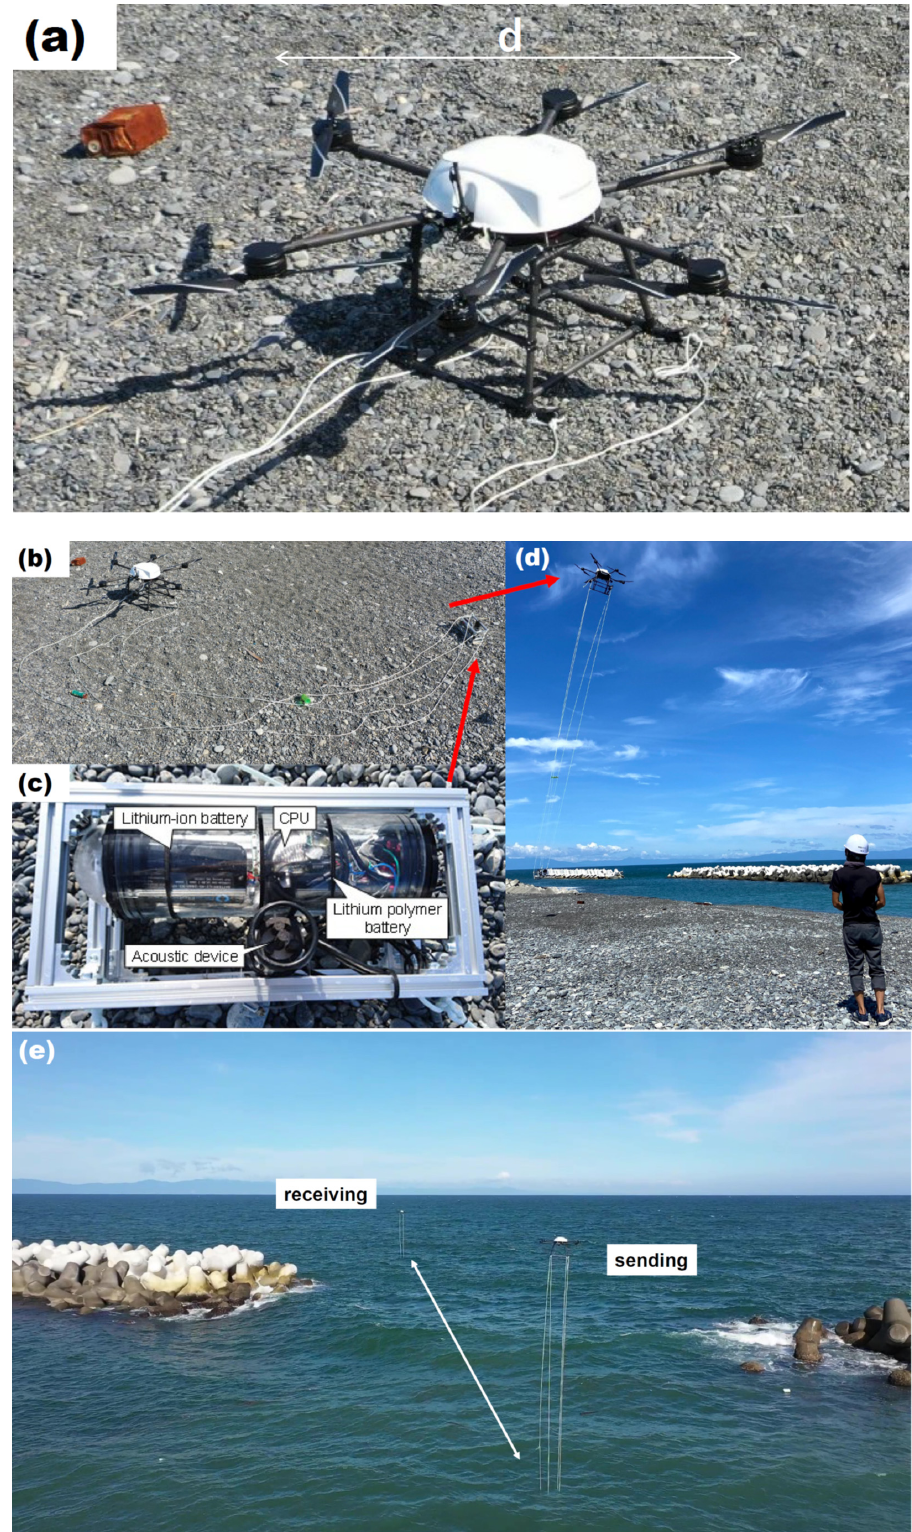
Figure 3. (a) The UAV used in the experiment in Section 3.1. (b) Observing UAV with an underwater Figure 3. ( a ) The UAV used in the experiment in Section 3.1. ( b ) Observing UAV with an underwater communication device suspended by nylon ropes. (c) Suspended device. The batteries, CPU, and communication device suspended by nylon ropes. ( c ) Suspended device. The batteries, CPU, and acoustic device are included in one container. (d) UAV takeoff. At the lower right is the operator- acoustic device are included in one container. ( d ) UAV takeoff. At the lower right is the operator- controlling the UAVs. (e) Receiving UAV moving slowly away from the sending UAV. controlling the UAVs. ( e ) Receiving UAV moving slowly away from the sending